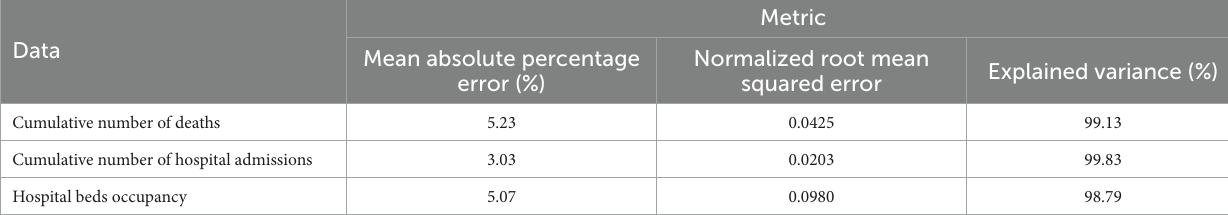
TABLE 1 Statistical analysis to compare the officially reported pandemic data and the model results.